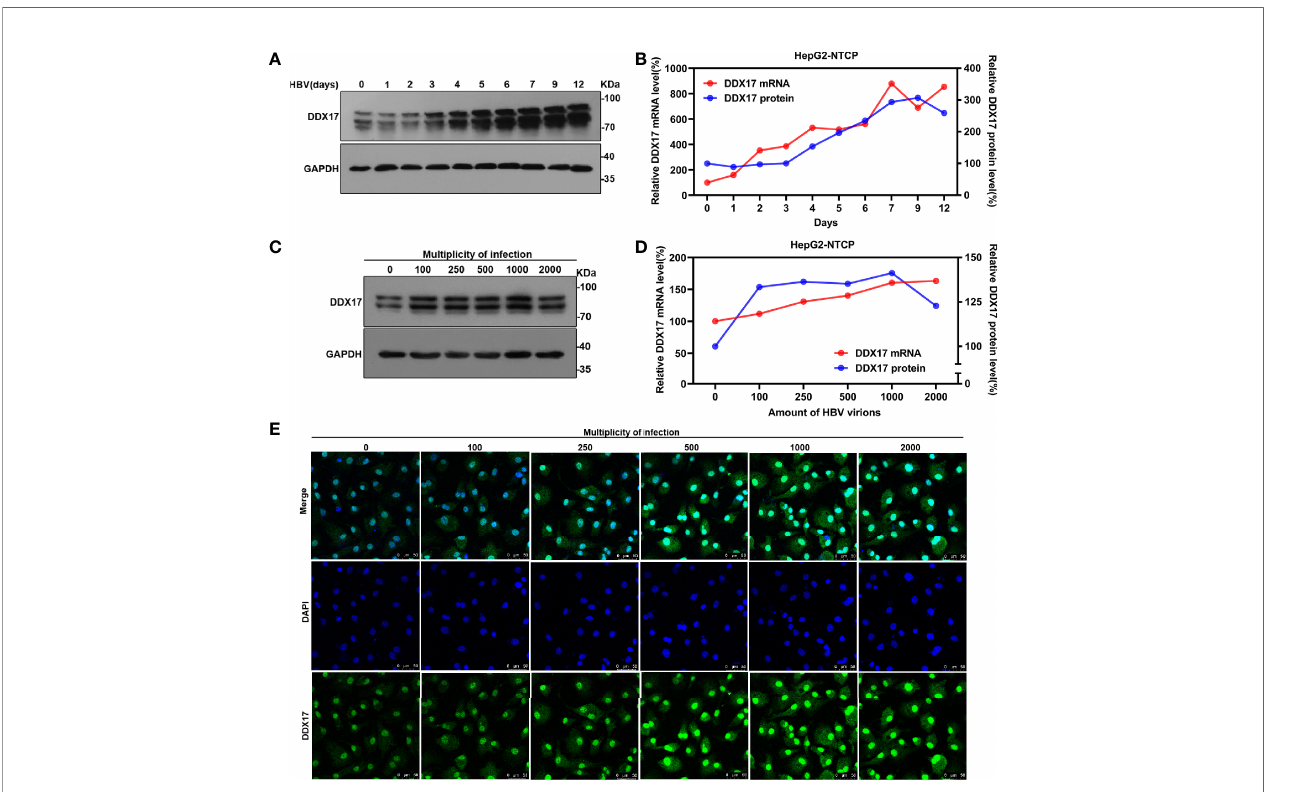
FIGURE 2 | The effect of HBV on DDX17 expression were analyzed in HBV-infected HepG2-NTCP cells. (A, B) HepG2-NTCP cells were infected with HBV (1, 000 genome equivalents/cell) and harvested at indicated days. Real time PCR and western blot measured the mRNA and protein level of DDX17, respectively. (C, D) HepG2-NTCP cells were infected with series dose of HBV particle and harvested at 5 days post-infection. Real time PCR and western blot measured the mRNA and protein level of DDX17, respectively. (E) Endogenous DDX17 level in HepG2-NTCP cells which infected with series doses of HBV particles was determined by immuno fl uorescence